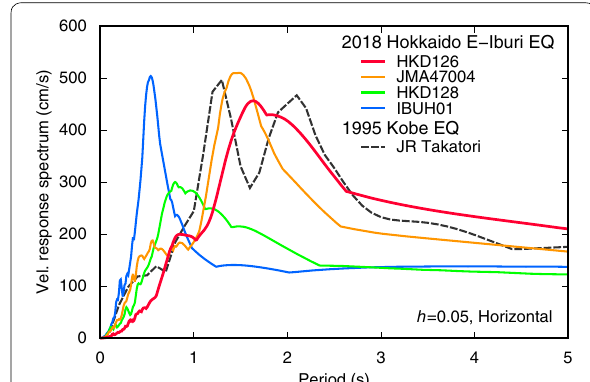
Fig. 3 Horizontal velocity response spectra. The horizontal velocity response spectra for four stations and one notable station (JR Takatori) are shown. The horizontal response spectra were obtained according to the maximum of the vector sum of the two horizontal-component response histories for a specific natural period using the damping factor h 0.05. The JR Takatori record = was observed by the Railway Technical Research Institute (RTRI) (Nakamura et al. 1996) Fig. 4 S-wave horizontal-to-vertical spectral ratios at HKD126. The red line represents the spectral ratio for main shock; a blue line with the light blue shadow represents the average spectral ratio and the standard deviation for weak